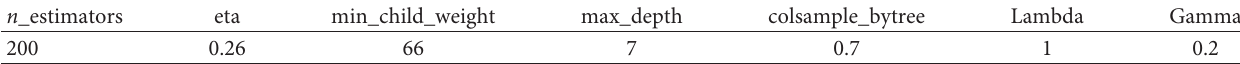
Table 5: The optimal parameter combination of the XGBoost prediction model.